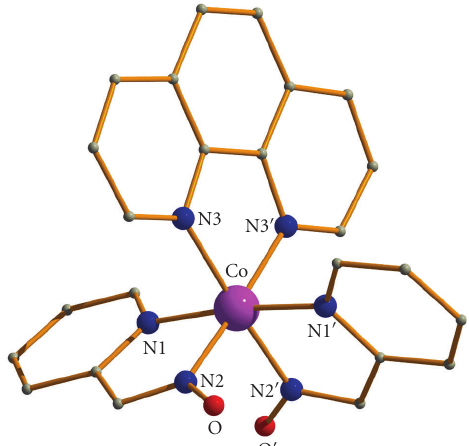
Figure 2: Partially labeled plot of the molecular structure of the cation that is present in 1 · 2H 2 O. Primes are used for symmetry related atoms. H atoms have been omitted for